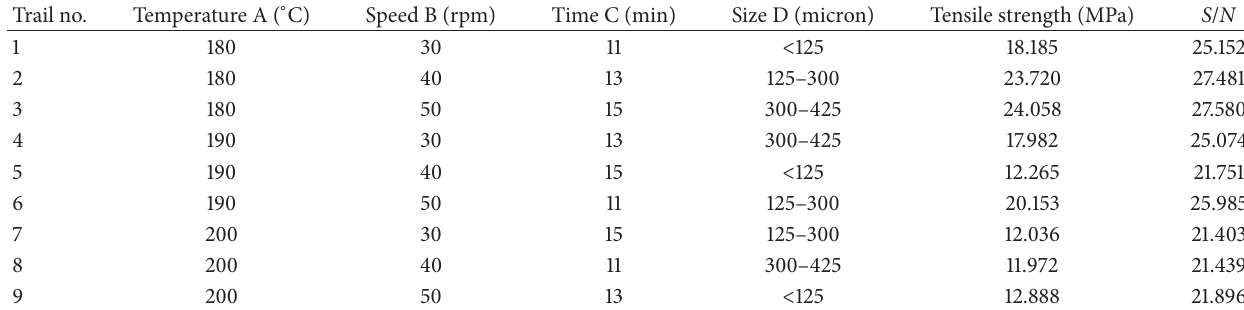
Table 5: Summary of the experimental results.